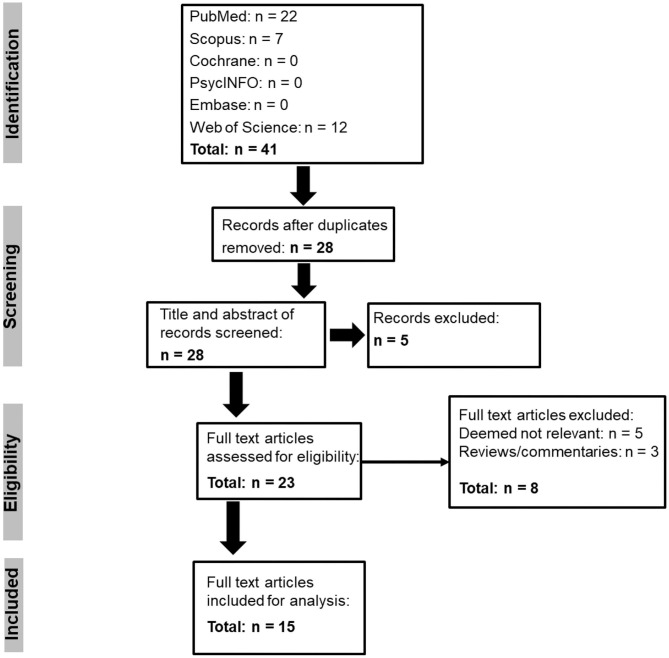
PRISMA flow-diagram.